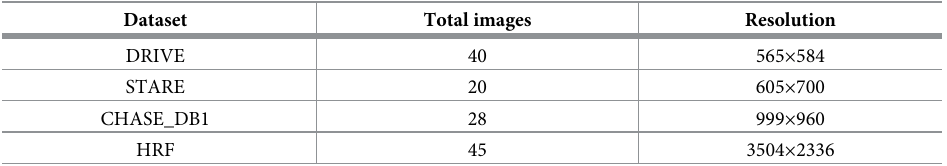
Table 1. Distribution of vessel segmentation